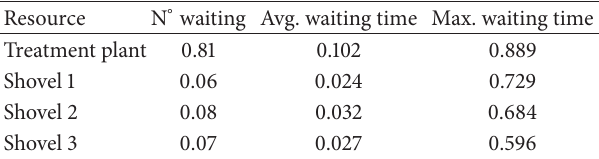
Table 3: Simulation